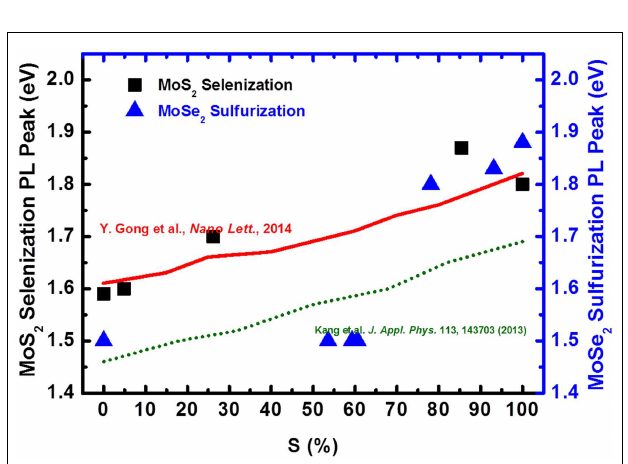
FIGURE 9 |The optical gap of selenization (square symbol) and sulfurization (triangle symbol) with the variation of Sulfur composition is shown .The experimental from Gong et al. (solid line) and theoretical results (dash line) are for references.